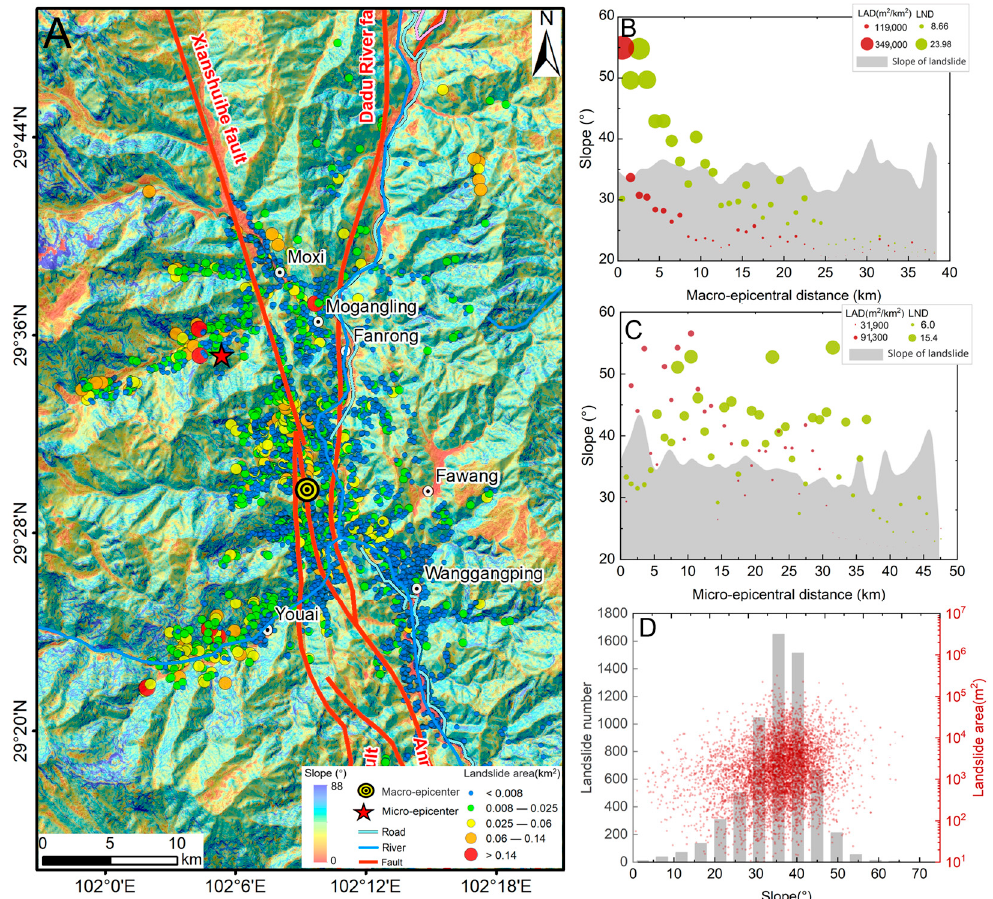
Figure 11. ( A ) coseismic landslide distribution with slope angle; ( B , C ) slope angle with macro- and micro-epicentral distance; ( D ) individual landslide distribution with slope angle.